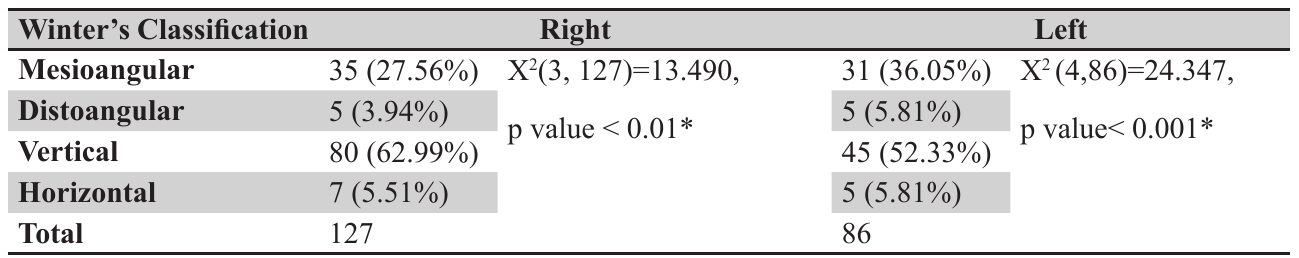
Table 3: Darkening of roots in respect to Winter’s Classification of type of impaction of mandibular third molar. Winter’s Classification